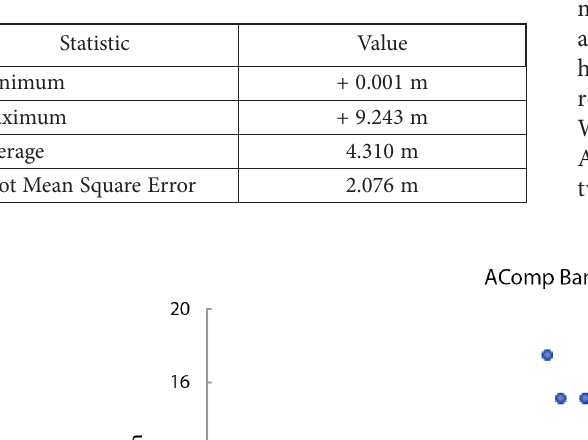
Table 2. Statistical evaluation of bathymetry retrieval in